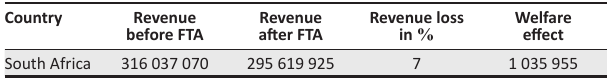
TABLE 5: Revenue and welfare impacts on South African market after liberalisation (US$). Country Revenue Revenue Revenue loss before FTA after FTA in